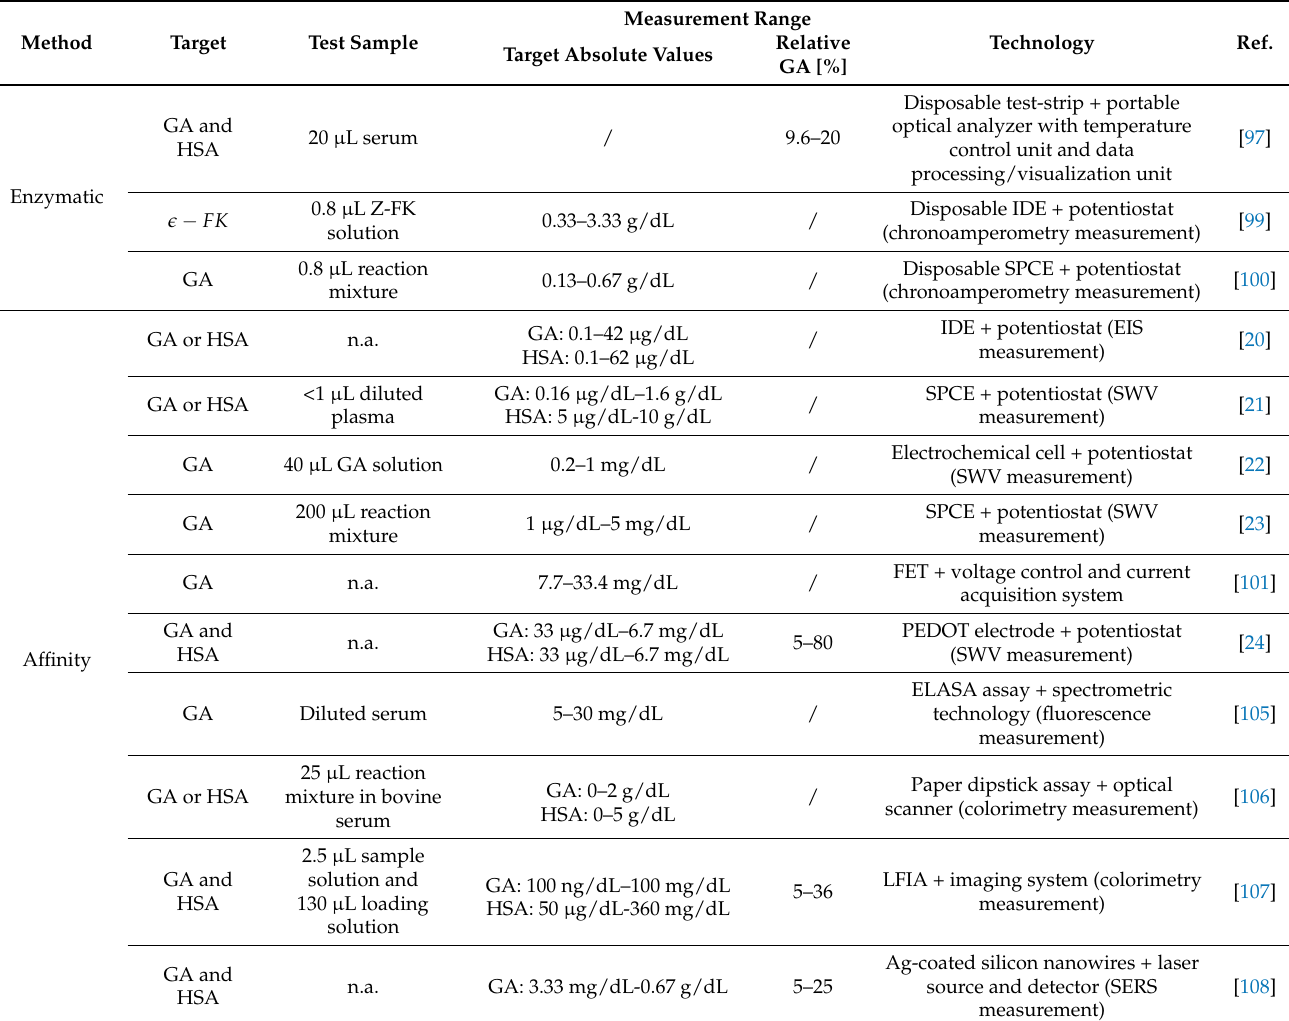
Table 7. Synthesis of the information and performances of the biosensors for POC glycated albumin analysis presented in this